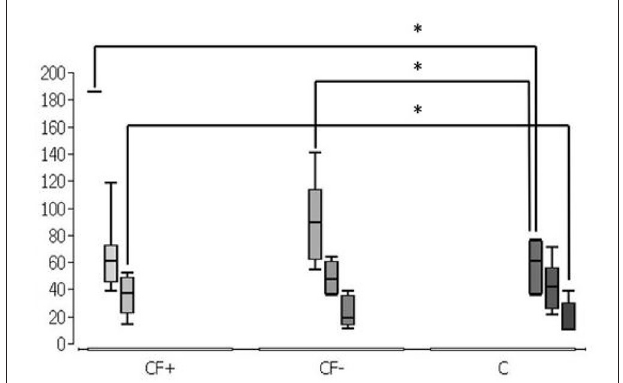
FIGURE 2 | Grouped representation of the respective application methods, combined representation. Simultaneous spraying of colistin and fibrin glue (CF + ), consecutive spraying of colistin and fibrin glue (CF-) and without fixation of colistin by fibrin glue (C). Significantly higher values in CF + group at 1h against CF- and C and in CF- against C. Furthermore, significantly higher values in CF + at 4h against C ( n = 7 per group and timepoint). * p < 0.05.